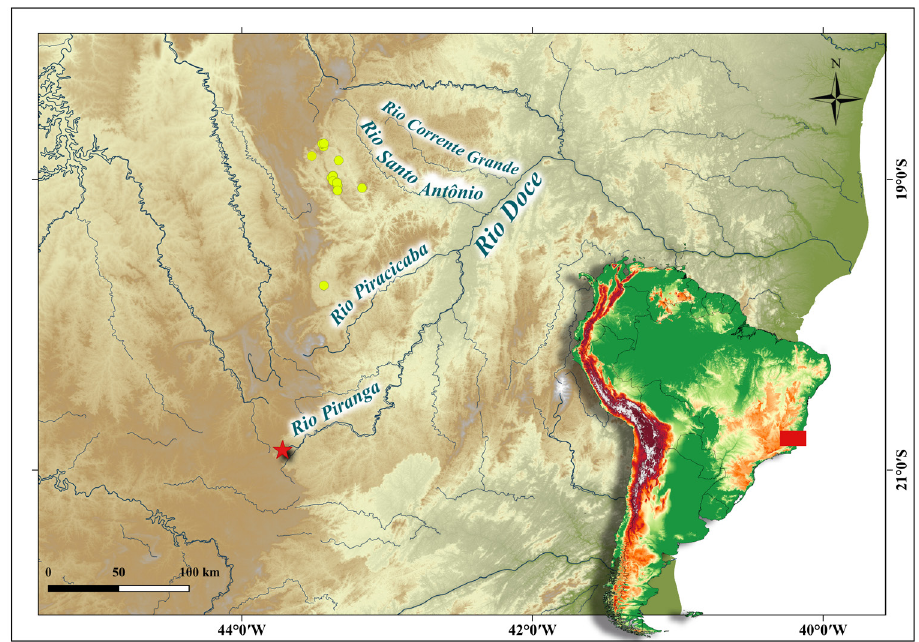
FIGURE 5 | Map of the rio Doce basin, Brazil, showing the type locality (red star) and collection sites (yellow circles) of Characidium krenak from rio Piranga and rio Santo Antônio sub-basins; each symbol may represent more than one